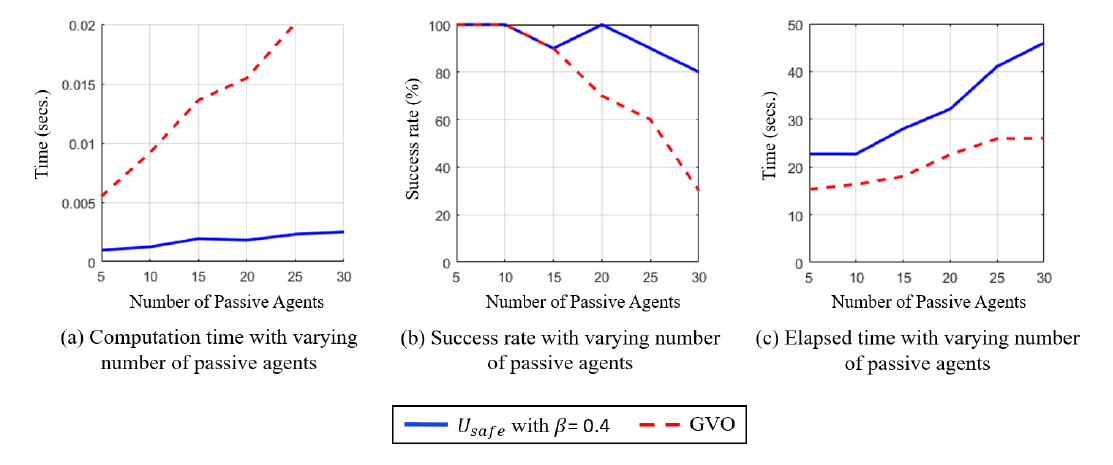
Figure 9. It shows the performance of GVO algorithm and the proposed U safe approach. The effect on average computation time, success rate, and elapsed time, are shown against varying number of passive agents. GVO: Generalized Velocity Obstacle.